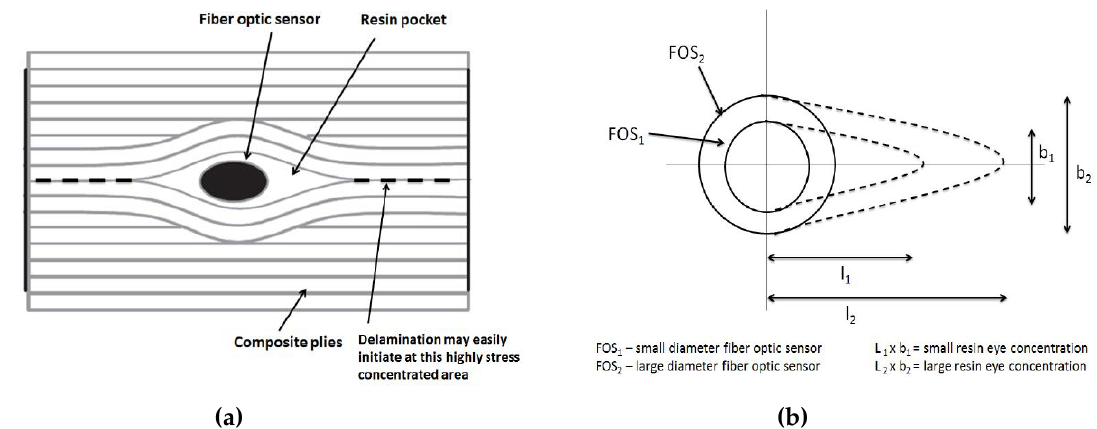
Figure 2 . Different resin eye concentrations depending on the diameter and their effect - ( a ) Resin eye concentration around FOS position in composite, ( b ) Resin eye concentration around various diameter FOSs.